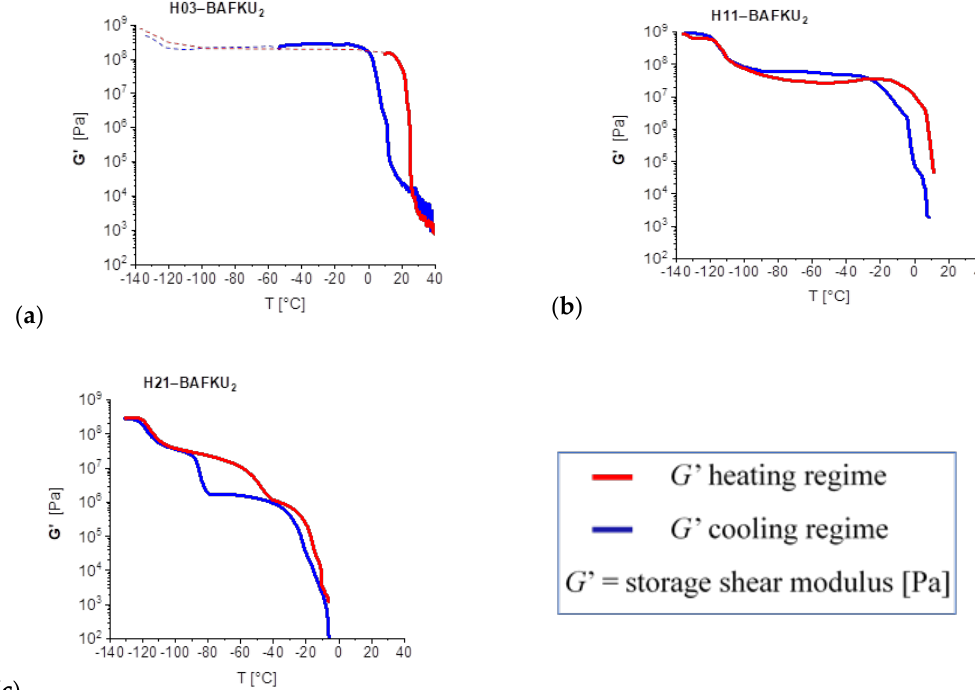
Figure 1. Dynamic-mechanical thermal analysis (DMTA) profiles (temperature-dependent storage modulus G’ only) of the copolymers ( a ) H03–BAFKU 2 , ( b ) H11–BAFKU 2 , and ( c ) H21–BAFKU 2 , recorded as heating and cooling scans.